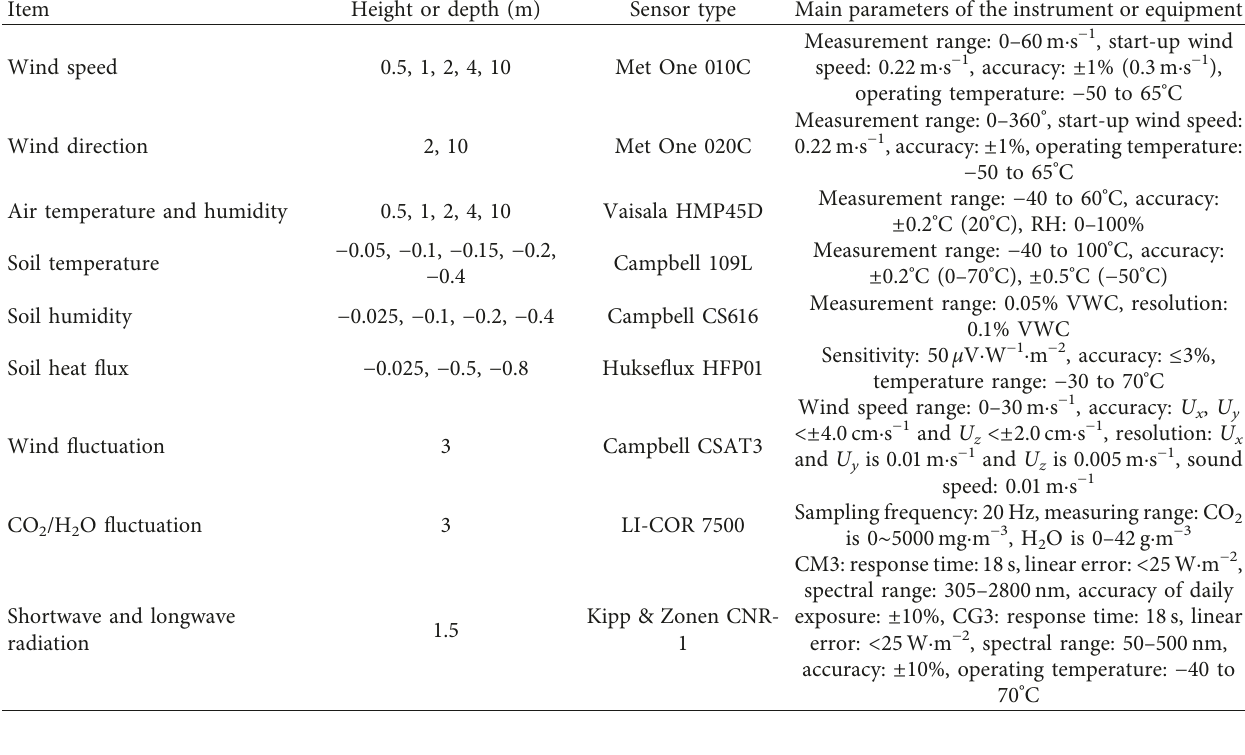
Table 1: Equipment and parameters of the land-air interactive observation system at the Tazhong